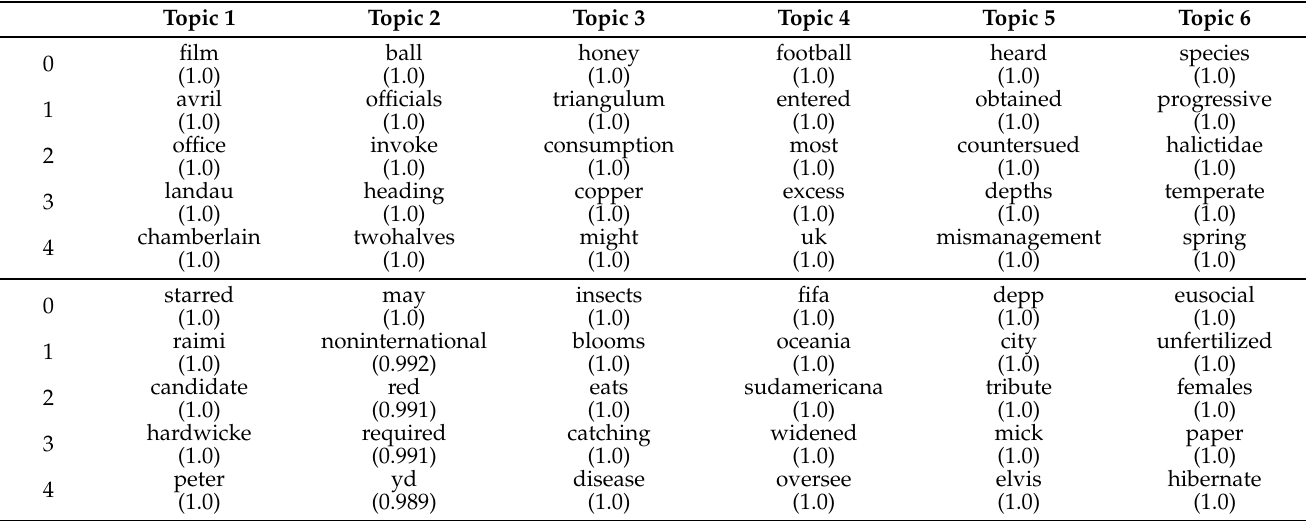
Table A15. For the most significant two words per topic, the four nearest neighbors based on cosine similarity are listed.